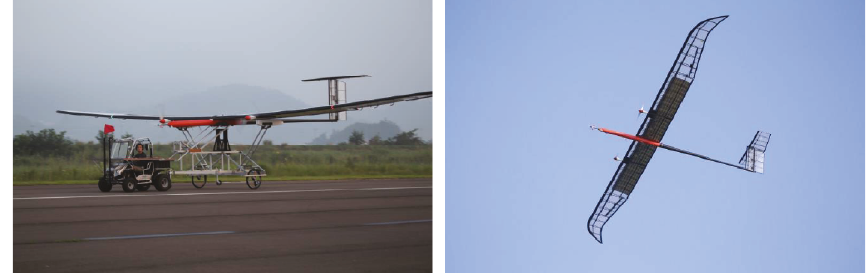
Figure 24: Flight test of EAV-3.